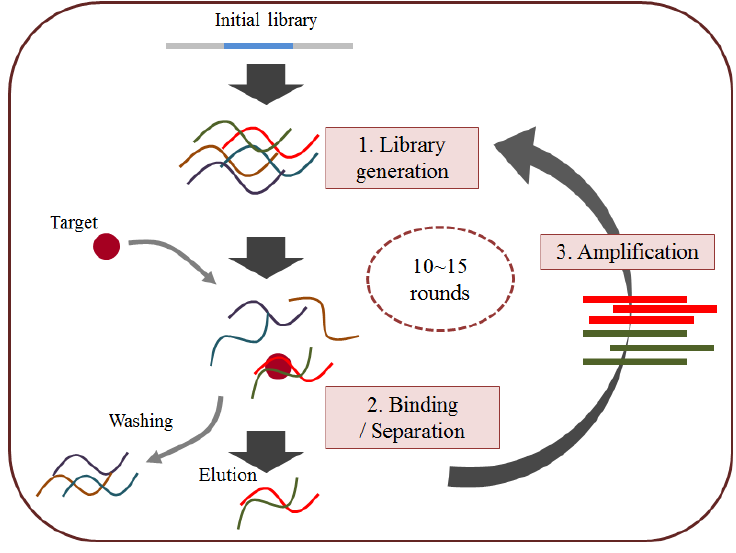
Figure 2. The general SELEX strategy. Starting with combinatorial libraries (first step), the specific binders are isolated by an iterative process of ligand binding, elution (second step), and amplification (third